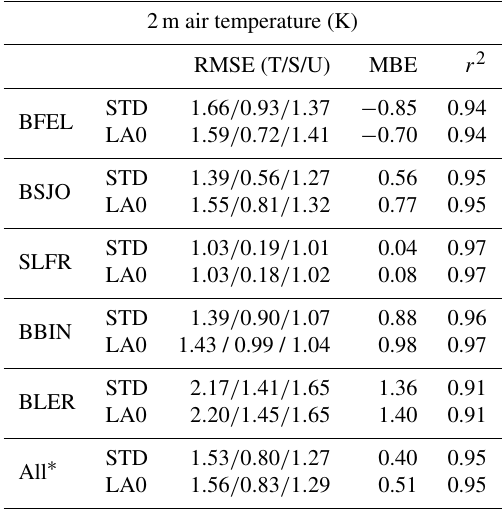
Table 5. RMSEs, MBEs and r 2 of the simulated 2m air temperature T 2m at the BFEL, BSJO, SLFR, BBIN and BLER sites during the study period. In addition to the total RMSEs (T), the systematic (S) and the unsystematic (U) RMSEs are listed. The statistics are pro- vided for the standard simulation (STD) and the simulation without street trees (LA0).